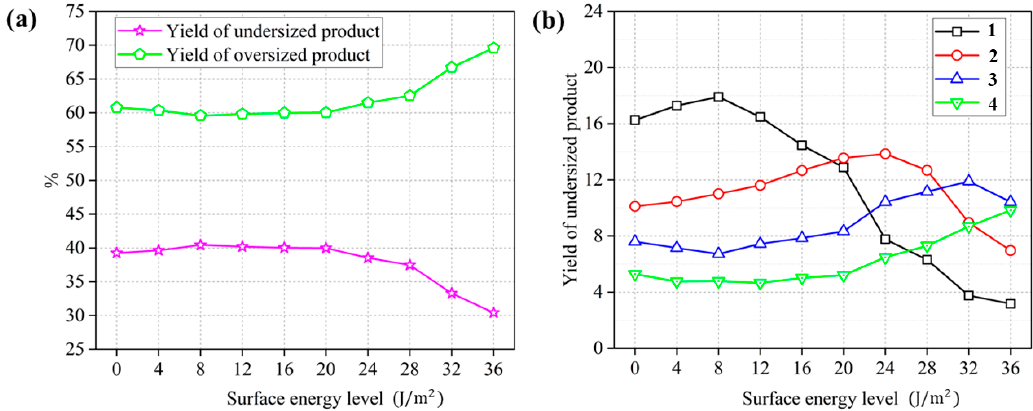
Figure 8. ( a ) Distribution of the yields between the undersized and oversized product with different surface energy levels; ( b ) The undersized product yields of each section with different surface energy levels.